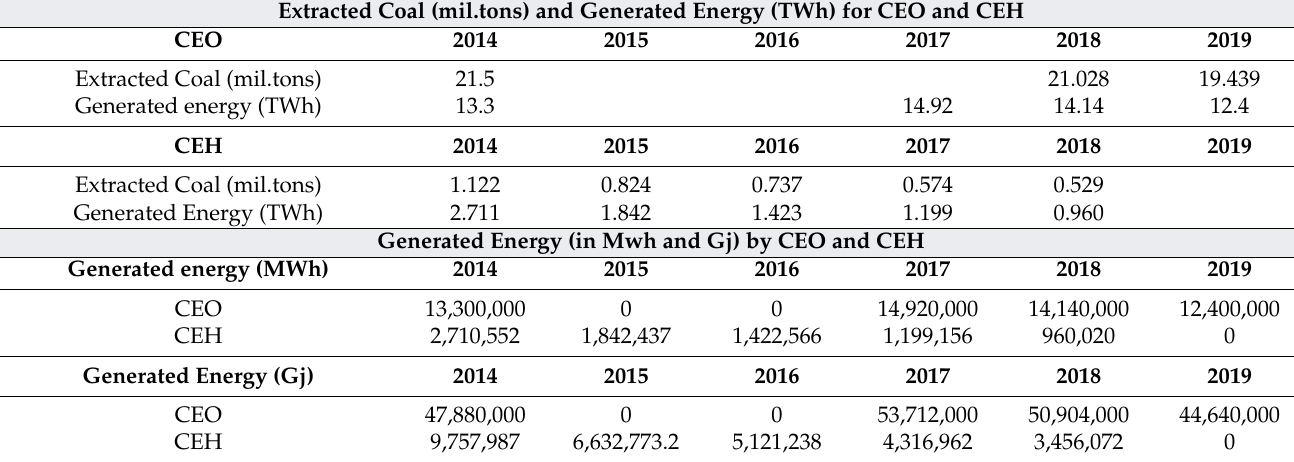
Table A2. Data used for calculations of the efficiency in energy production for CEH and CEO [84,85]. Extracted Coal (mil.tons) and Generated Energy (TWh) for CEO and